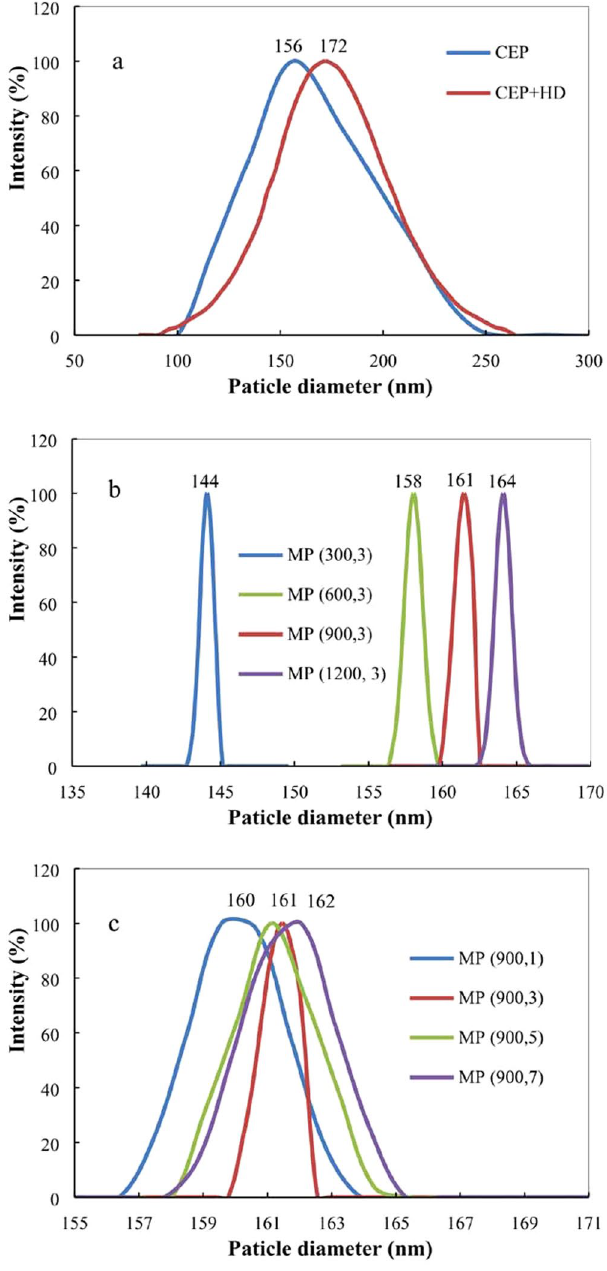
Figure 4. Particle size and particle size distribution of polyacrylate particles prepared via CEP and CEP + HD. ( a ) MP under different homogenizer pressure ( b ) and pass number ( c ). CEP denotes conventional emulsion polymerization, CEP + HD represents the emulsion containing HD synthesized by CEP, MP (m, n) signifies miniemulsion polymerization through homogenizer pressures of m, and pass number of